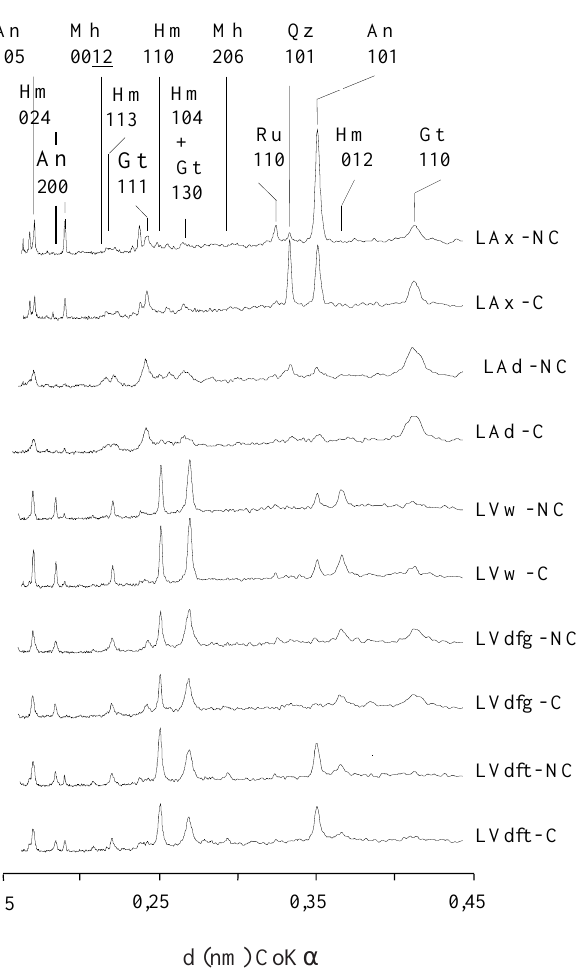
Figura 2. Difratogramas de raios-X da fração argila ferro-concentrada. Gt = Goethita; Hm = Hematita; An = Anatásio; Qz = Quartzo; Ru = Rutilo; Mh =